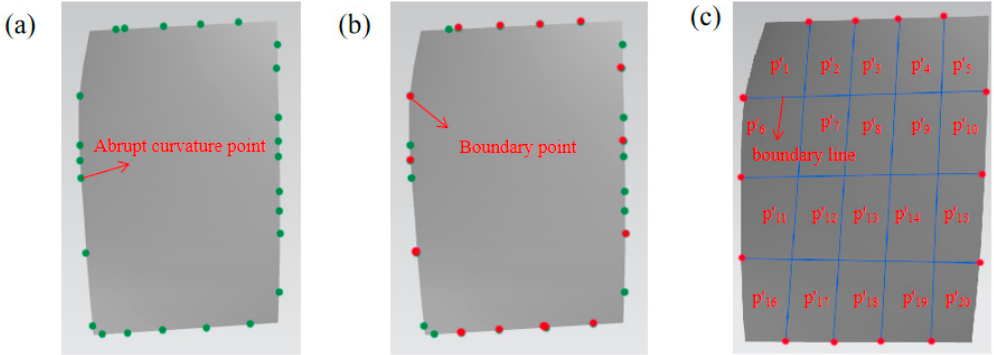
Figure 6. Region division of ruled blade P’: ( a ) distribution of abrupt curvature points, ( b ) extract boundary points for region division, ( c ) region division of blade.